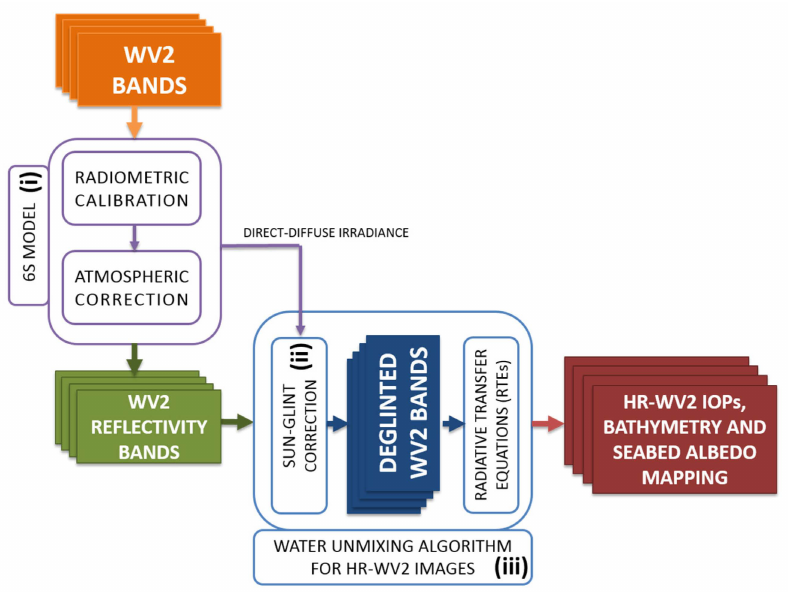
Figure 1. Schematic procedure of the proposed multispectral high resolution WorldView-2 processing chain for shallow coastal waters